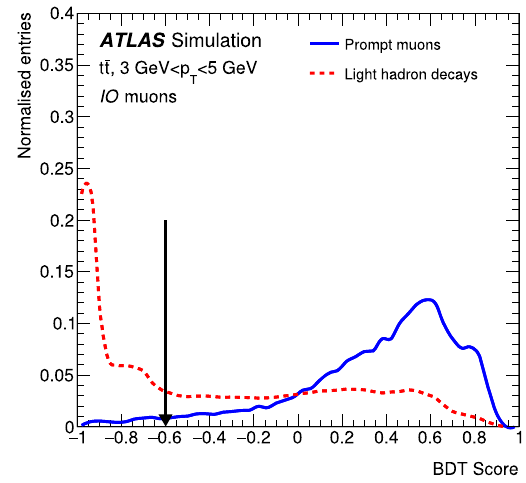
Fig. 3 Distributions of the gradient BDT score for muons recon- structed with the IO algorithm (left) and CB algorithm (right) in simu- lated t ¯ t events. The distributions are shown for prompt muons (full line,